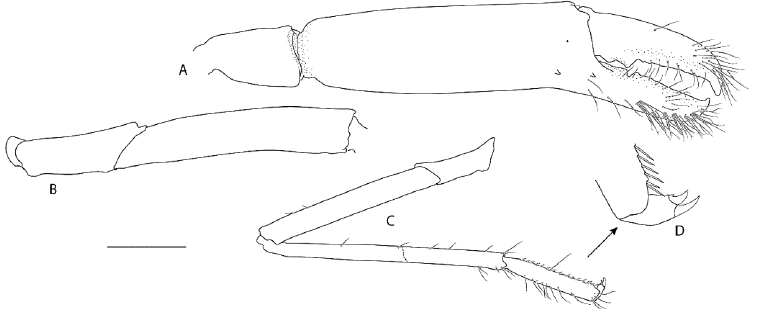
Figure 19. Spongicaris antipodes sp. nov., holotype F ov. (NMNZ CR.025704). ( A ) Right P3, distal portion, lateral. ( B ) Right P3, proximal portion, lateral. ( C ) Left P5, lateral, with enlarged detail of dactylar spination enlarged. Scale bar = 2 mm. Etymology. Named antipodes , an archaic vernacular for Australia and New Zealand, as this species is so far restricted to the southwestern Pacific region. The term is used as a noun in apposition. Description of holotype female (Figures 18 and 19). Body robust, surface generally glabrous. Rostrum narrowly triangular in dorsal view, one-third (0.3) as long as PCL, horizontal, nearly reaching to distal end of antennular peduncle; dorsal margin with 7 small teeth or granules and small posterior blunt eminence at level of posterior orbital margin; ventral margin with three small teeth in distal one-third; ventrolateral ridges with 1–2 (right-left) small teeth on distal half. Carapace glabrous, not inflated. Cervical and branchiostegal grooves distinct, seven (right)–eight (left) distinct spines line cervical groove. Postrostral region with two small submedian spines on either side; two pairs of postorbital spines; hepatic region smooth; four pairs of anterolateral spines; two small spines on anterior branchial region; otherwise carapace surface is smooth. Orbital margin concave, inferior orbital angle slightly produced and furnished with one small antennal spine (left) or granule (right); branchiostegal spine small to minute; pterygostomian angle round, with 1–2 spines on margin. Thoracic sternites 6–8 anteriorly rounded, minutely serrate but unarmed; sternite 6 posterior margins evenly concave. Pleonal somites glabrous, surfaces smooth. First pleonite shortest; divided into two sections by distinct transverse carina; ventral margin continuous, straight. Second to fourth pleonites subequal in length, with feeble transverse carina and blunt articular knob; ventral margin rounded. Fifth pleonite with two small posteroventral granules on broad, round margin; dorsal surface smooth, unarmed; posterior margin with four small spines. Sixth pleonite dorsally smooth; posterolateral process straight, angular, with small spine at corner; posterior margin with three small spines. Pleonal sternites unarmed.